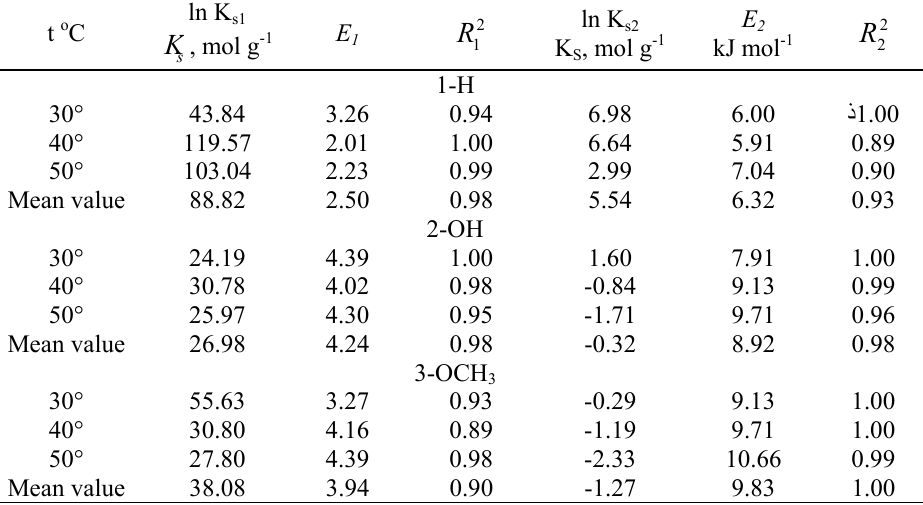
Table 6. D-RAIM parameters and correlation coefficients at different